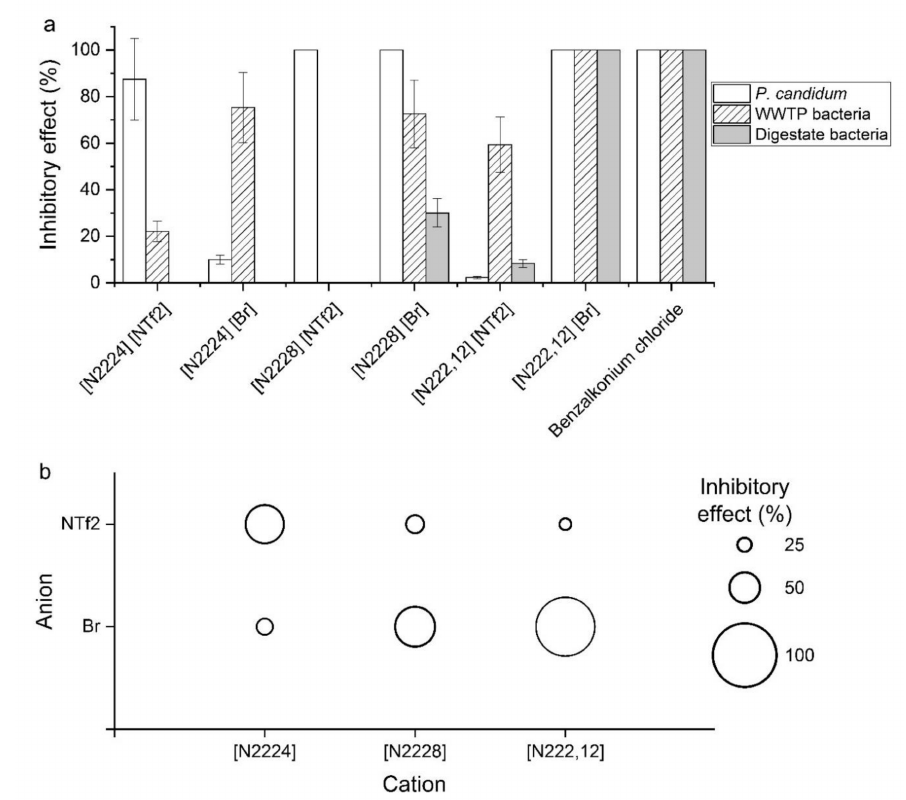
Figure 1. Inhibitory e ff ect of ILs on three groups of microorganisms. ( a ) Relative inhibitory e ff ect of QAS and their precursors, and standard inhibitor benzalkonium chloride, on the growth of Penicilium candidum , WWTP bacteria, and digestate bacteria. Bars represent standard deviations. ( b ) Visualization of inhibitory e ff ects on all tested species (calculated as a sum of partial e ff ects) concerning the anion and cation. ILs are aligned from left to right by extending the alkyl